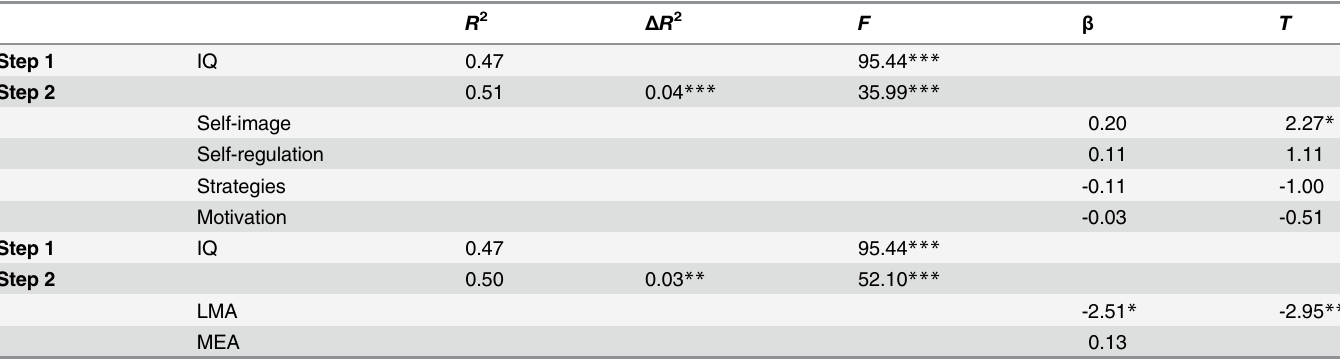
Table 2. Hierarchical Regression Analysis predicting mathematics achievement scores a from the mathematical metacognition and mathematics anxiety with the effect of IQ partialled